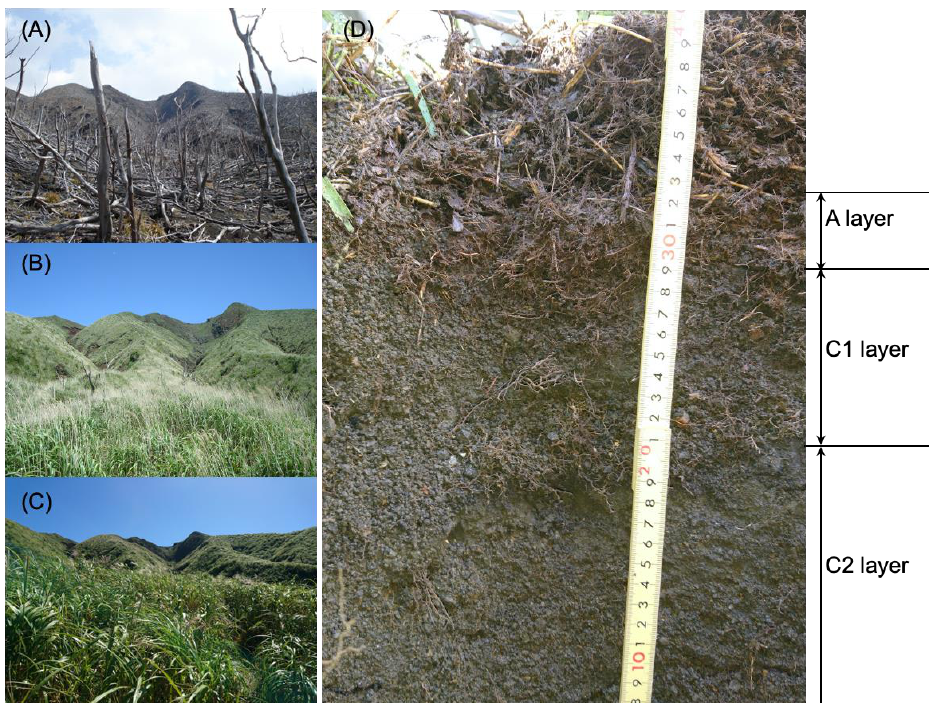
Figure 1. Vegetation damage and colonization of Miscanthus at site IG7. ( A ) March 2008; ( B ) May 2016; ( C ) September 2018; ( D ) soil profile in September 2018. A layer of bulk soil with the Miscanthus rhizosphere (0–11 cm); C1 layer, upper year 2000-volcanic deposits (11–22 cm); C2 layer, lower year 2000-volcanic deposits (>22